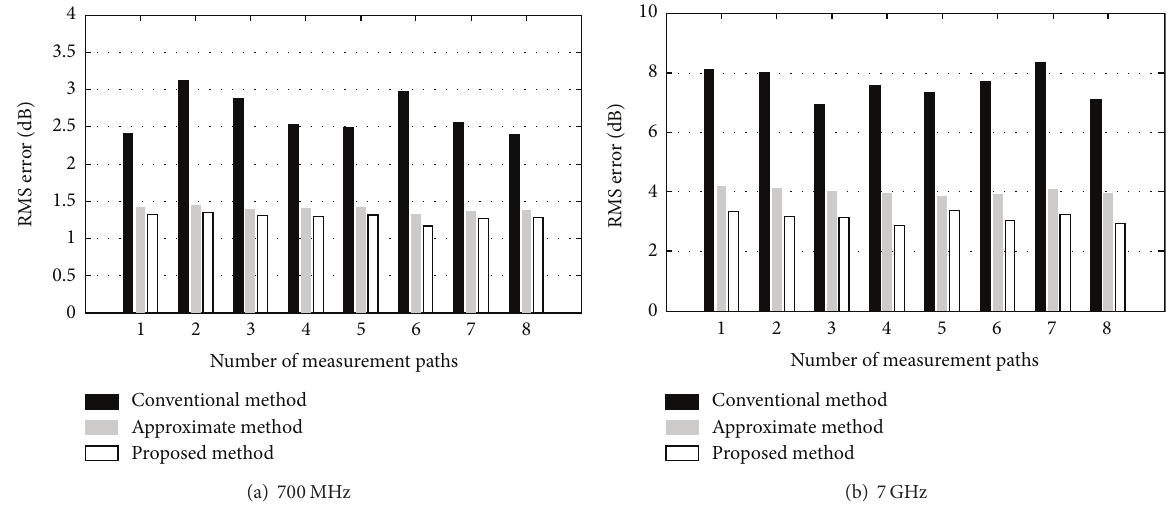
Figure 8: Comparison of RMS errors between measured results and simulated